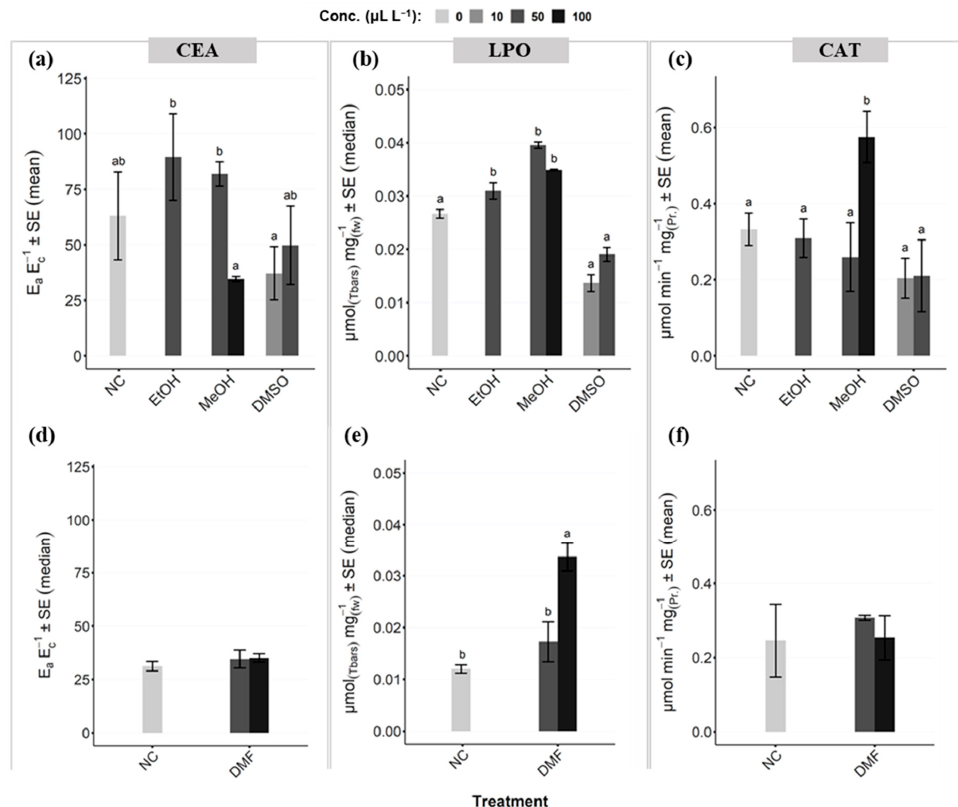
Figure 5. Biomarker analyses for Montipora digitata considering cellular energy allocation (CEA; ( a , d )), lipid peroxidation (LPO, ( b , e )), and catalase activity (CAT, ( c , f )) for the control (NC) and each treatment. The biomarker analyses were separated in the two sub-experiments, whereas ( a – c ) described the first sub-experiment testing ethanol (EtOH), methanol (MeOH), and dimethyl sulfoxide (DMSO), and ( d – f ) the second sub-experiment testing dimethylformamide (DMF) of different concentrations including controls. Different letters (i.e., a,b,ab) between treatments indicate significances, while same letters indicating no significant differences. When no letters were shown in general, no differences occurred between any of the